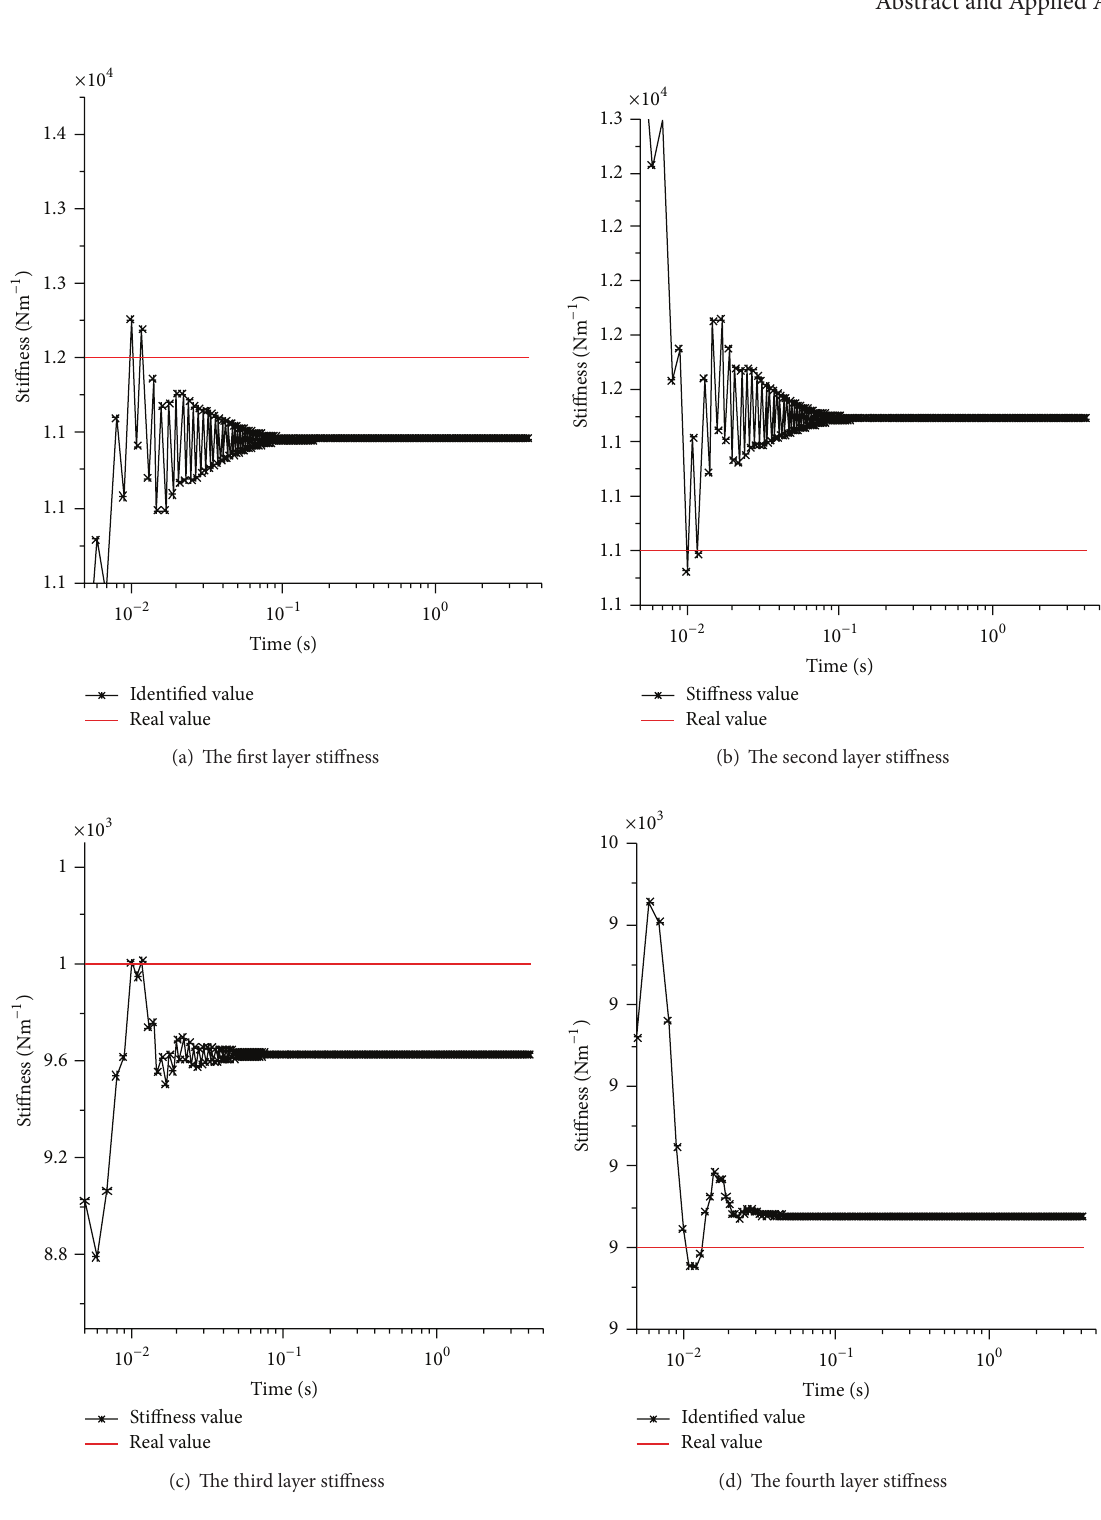
Figure 4: Stiffness identification results when SNR is